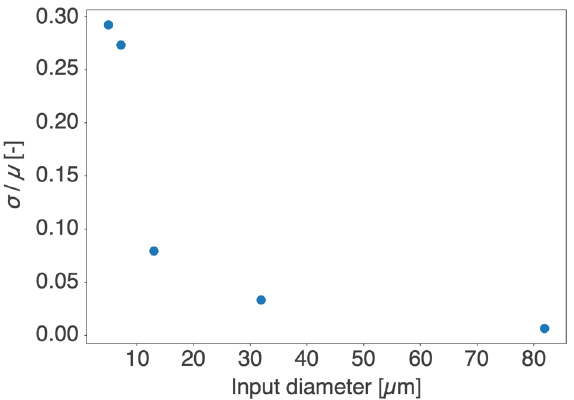
Figure 6. Standard deviation σ divided by the average µ of the 50 % diameter.